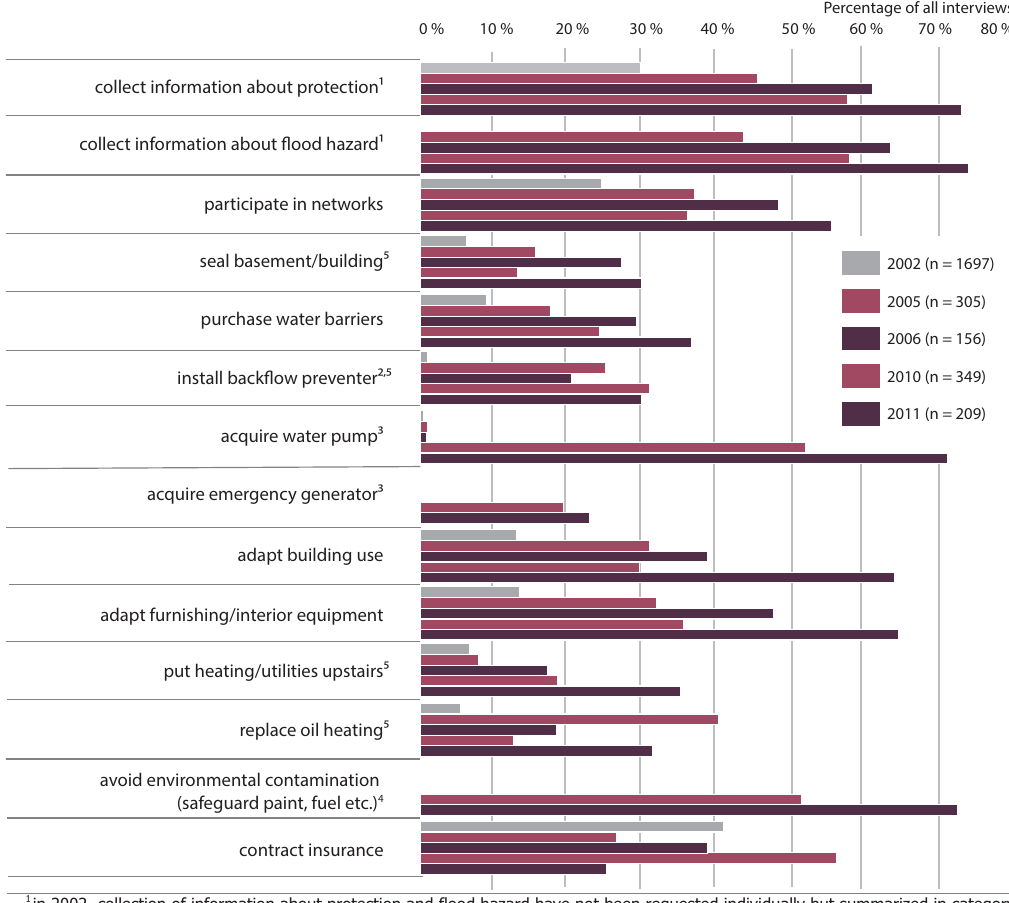
Figure 2. Precautionary measures performed by private households before the respective flood event.